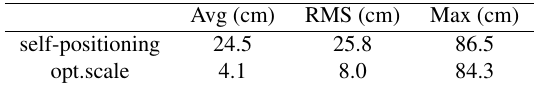
self-positioning